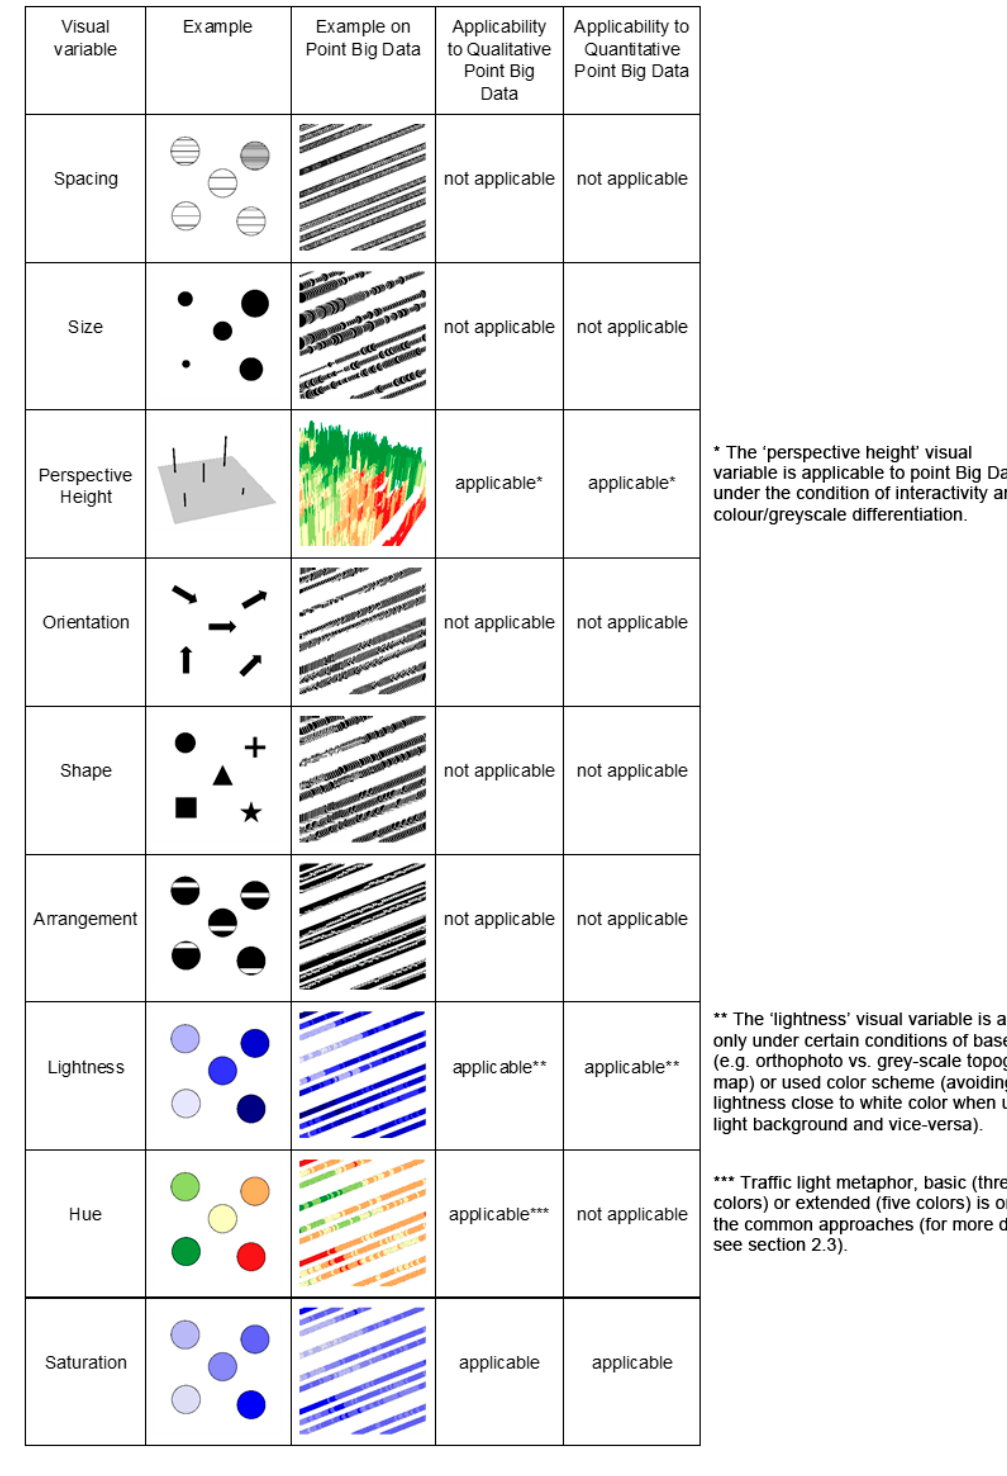
Figure 1. Applicability of visual variables to uncertainty of point Big Data.